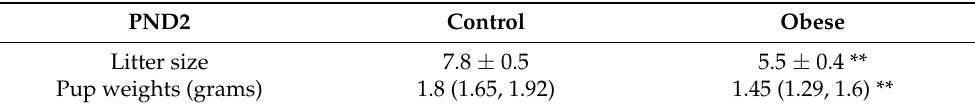
Figure 2. Dam morphometric and metabolic status data. ( Panel A ) Body weight trajectory from pre-gestation to weaning; ( B ) a comparison of body composition prior to mating (NP) with E18 gestation; ( C ) fed blood glucose at day 18 of gestation; ( D ) maternal total dissected visceral fat weights and liver weights at the end of the study (postnatal day 21). Data are presented as ± SEM, n = 8 per group. Significant differences are denoted **** p <0.001, ** p <0.01, * p <0.05. ns , not significant, i.e., p > 0.05. Table 1. The effect of maternal obesity on litter size and pup weights at postnatal day 2. Data are expressed as mean ± SEM for litter size and medians and interquartile ranges for pup weights. Litter size was analyzed by 2-tailed unpaired t-test while pup weights were analyzed by Kolmogorov– Smirnov test and the significant effects of obesity are indicated; ** p <